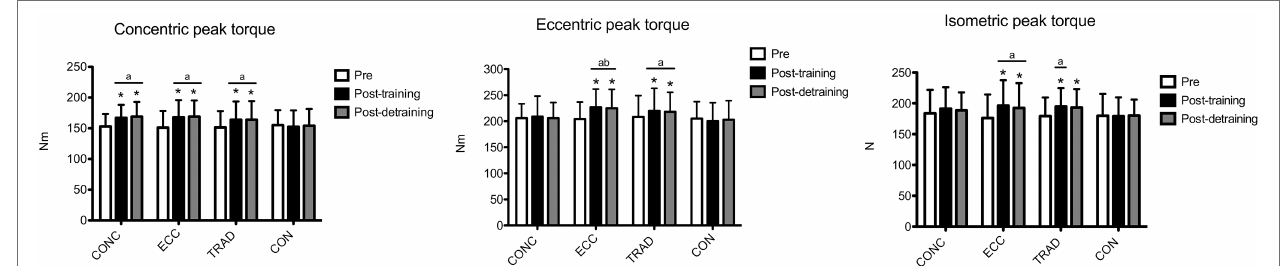
FIGURE 1 | The changes in contralateral concentric, eccentric, and isometric peak torque are shown for the concentric-only (CONC), eccentric-only (ECC), traditional concentric–eccentric (TRAD) volume-equated training groups and control (CON). Concentric peak torque similarly increased in all training groups more than CON and was similarly retained after the detraining period. Eccentric peak torque increased and was retained similarly in ECC and TRAD more than CON, but only ECC was different from CONC. Isometric peak torque increased similarly in ECC and TRAD more than CON, but TRAD did not differ from CON at post- detraining. * p < 0.05 vs. Pre; a p < 0.05 vs. CON; and b p < 0.05 vs.